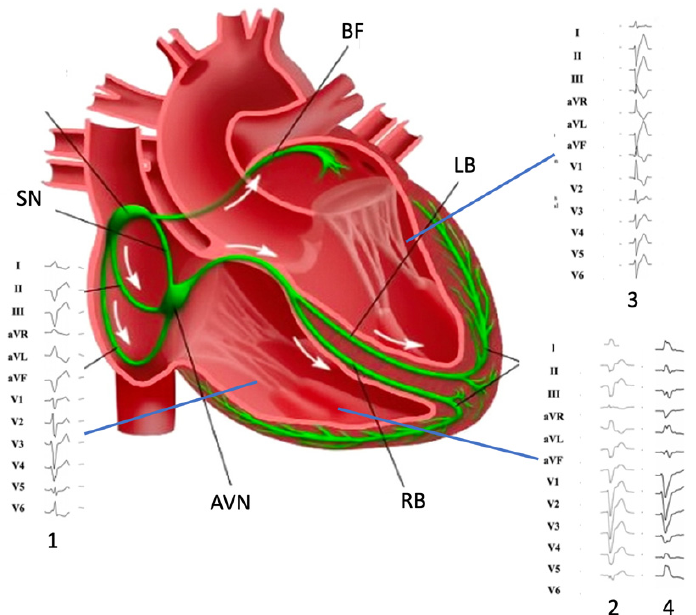
Figure 1. Morphology of premature ventricular complexes originating from (1) inferior tricuspid valve, (2) moderator band, (3) left posterior fascicle, and (4) moderator band (note DII/DIII dis- cordance). SN: Sinus Node; AVN: atrio-ventricular node; RB right bundle; LB: left bundle; BF: Bachmann’s